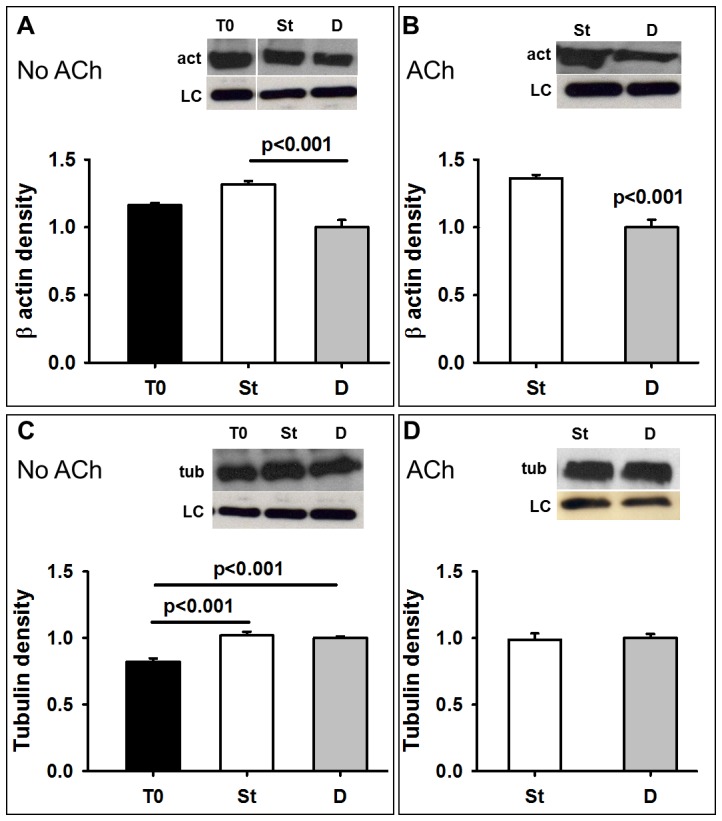
Tidal stretch differently regulates the tensile and compressive cytoskeletal elements.Effects of static and dynamic Ptm on β-actin (act, ∼42 KDa) (A and B) and α-tubulin (tub, ∼50 KDa) (C and D) in intact bovine airways after 90 min of mechanical loading with (B and D) or without (A and C) constriction assessed by Western blots. T0: time 0 before stretch, St: static Ptm. D: dynamic Ptm oscillation. GAPDH (∼35 KDa) is loading control. Data are normalized such that the mean of the dynamic group is unity.